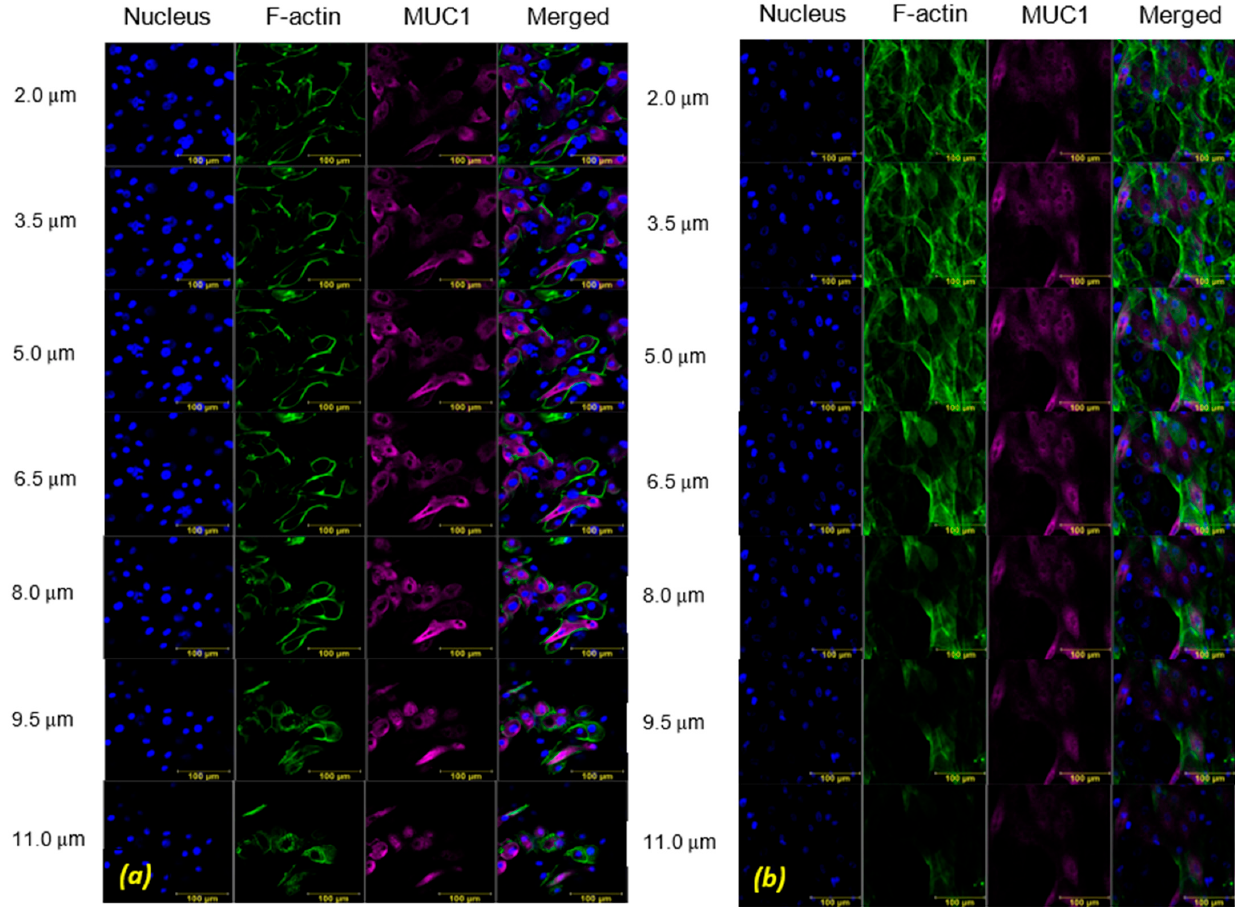
Figure 4. The Z-stack cross-section images of the human conjunctival epithelial cell (HCEC) in vitro model. ( a ) Unstressed control, ( b ) after exposure to wall shear stresses (WSS) of 0.5 dyne/cm 2 for 15 min. Immuno fl uorescence staining: nucleus (blue), F-actin (green), MUC1 (purple).